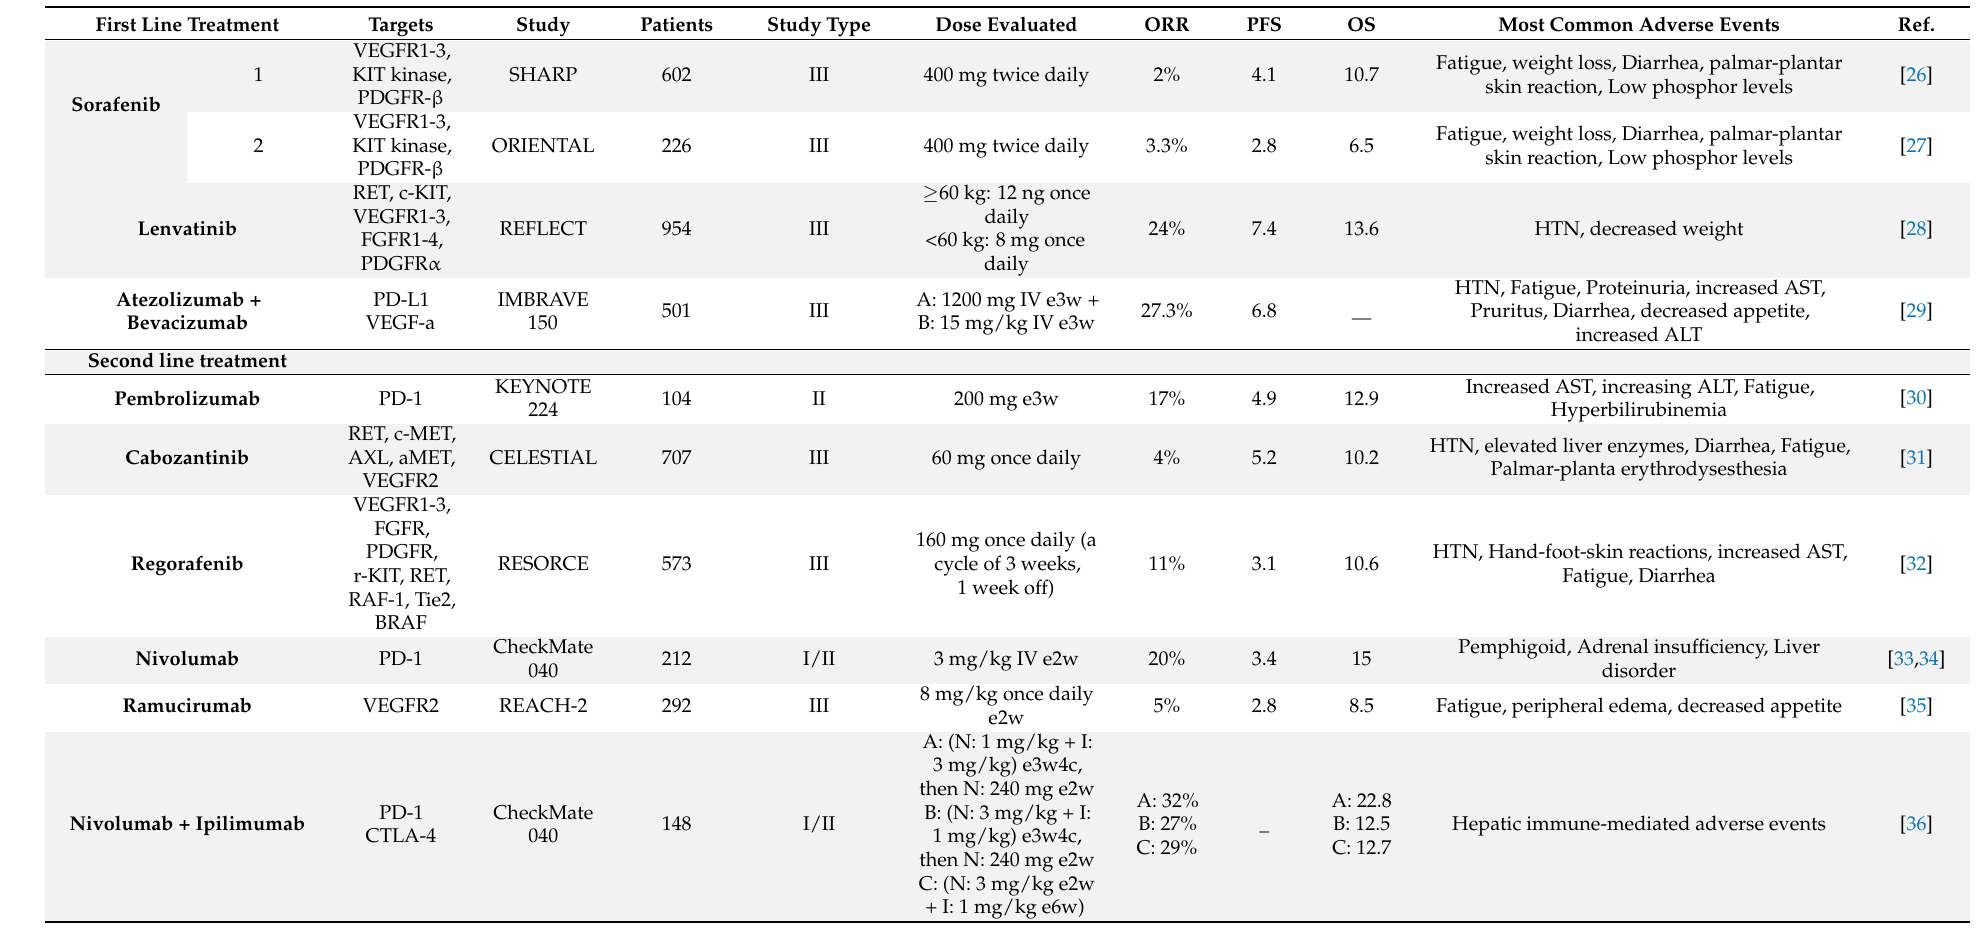
Table 1. Selected first-line and second-line FDA-approved agents for targeted therapies in advanced